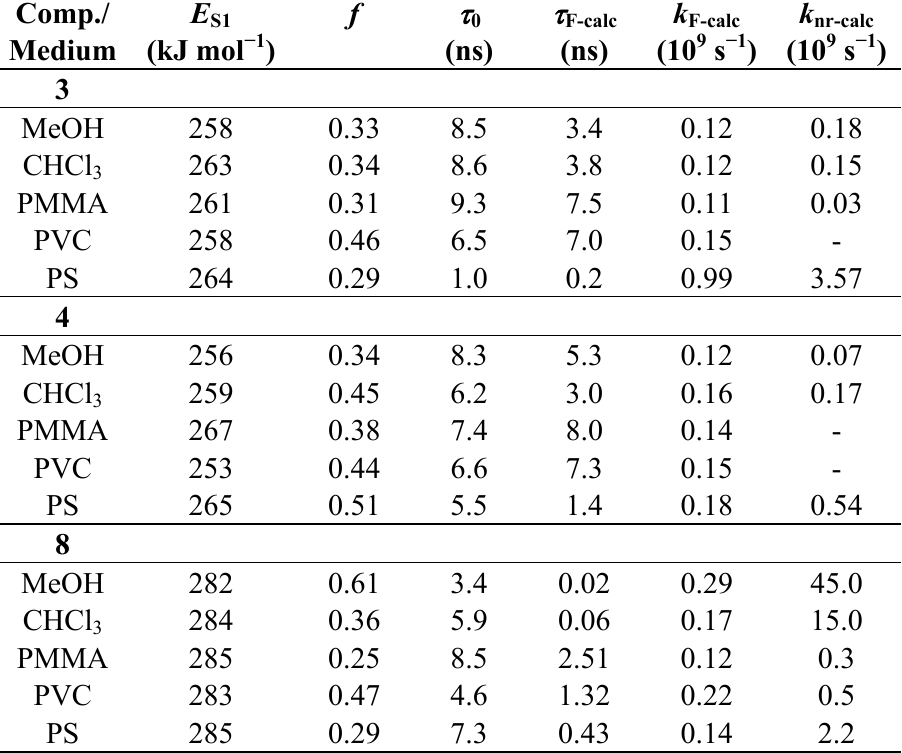
Table 3. Calculated spectral properties of 3 , 4 and 8 , based on spectral